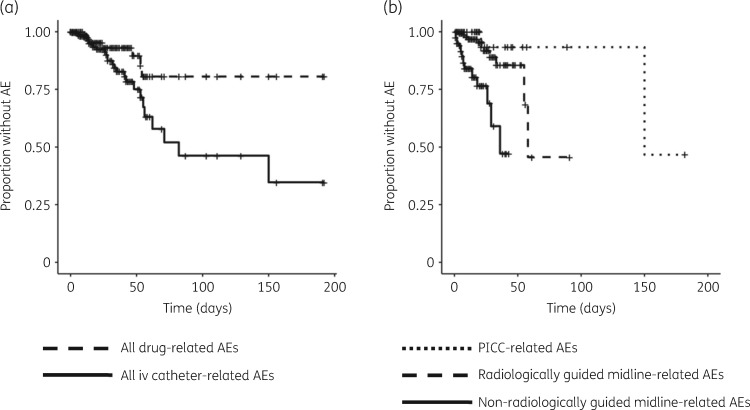
Rate of OPAT-related AEs. Kaplan–Meier plots demonstrating (a) AEs attributed to either drugs or iv catheters and (b) catheter-related AEs stratified by route of iv access. AEs are indicated by censored events on plots.